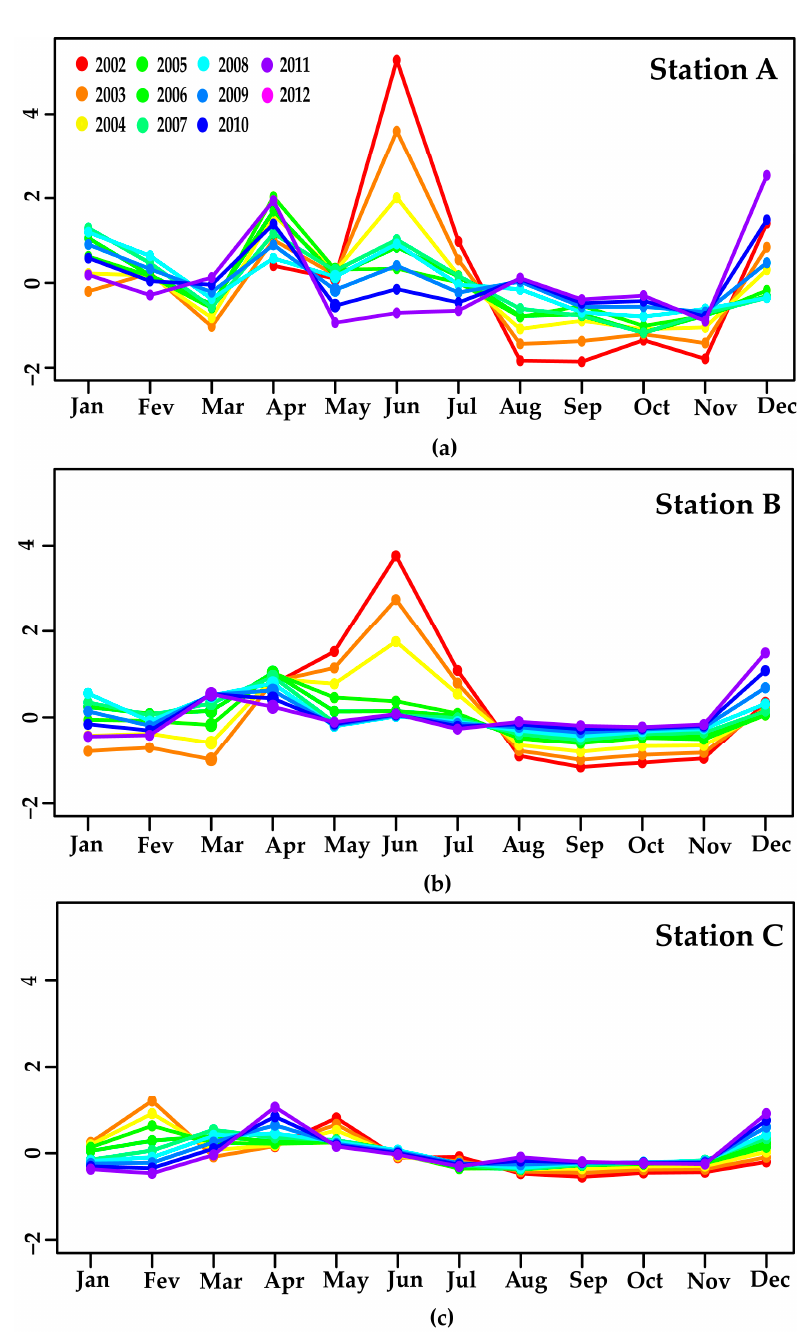
Figure 8. Inter-annual variability of the seasonal component of the MERIS water constituent Algal Pigment Index 1 (API 1) at: ( a ) Station A; ( b ) Station B; and ( c ) Station C. Each line represents a year from 2002 to 2012.